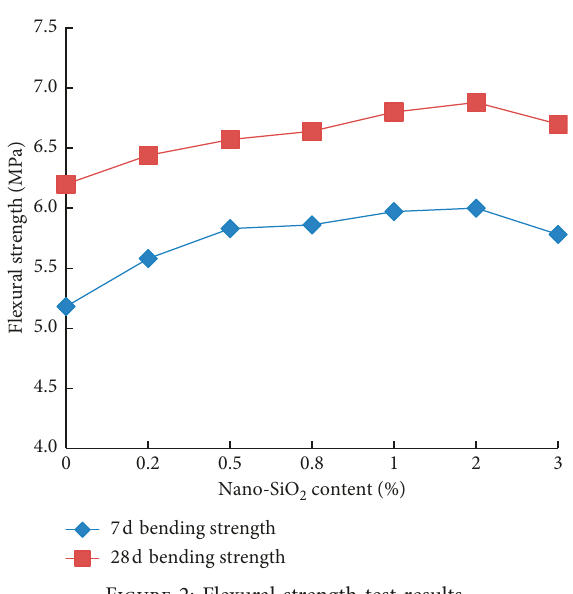
Figure 3: Compressive strength test